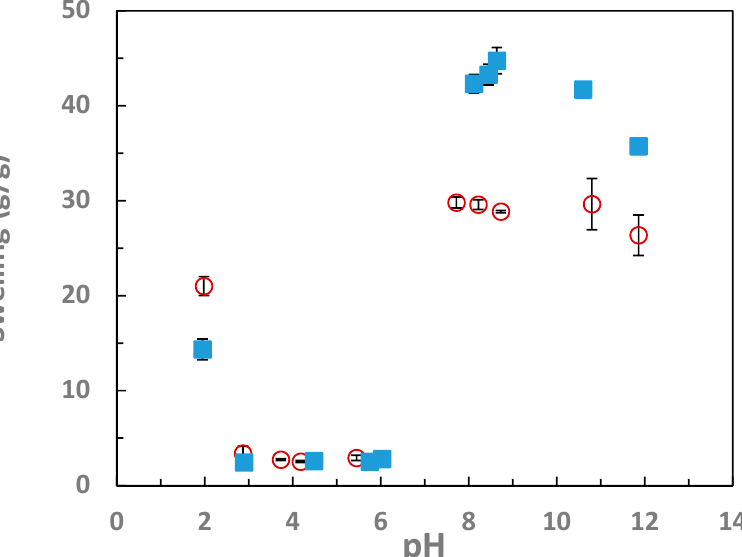
Figure 1. IPN swelling degree as a function of solution pH. The sharp decrease in swelling between pH 3 and 6 is consistent with charge complexation of the two networks. IPNs of PAAm/PNVF and PNVF/PAAm were partially hydrolyzed to PVAm/PAAc (blue closed symbols) and PAAc/PVAm (red open symbols).